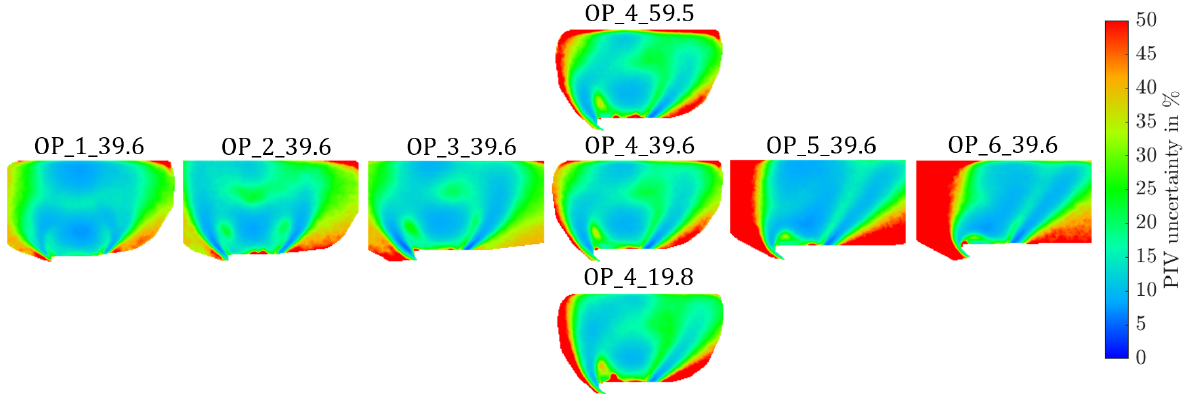
Figure 10. Median of percentage PIV uncertainty in the individual velocity fields of different valve lifts and mass flow rates. Nomenclature: OP_4_39.6 = 4 mm valve lift, 39.6 kg/h mass flow.